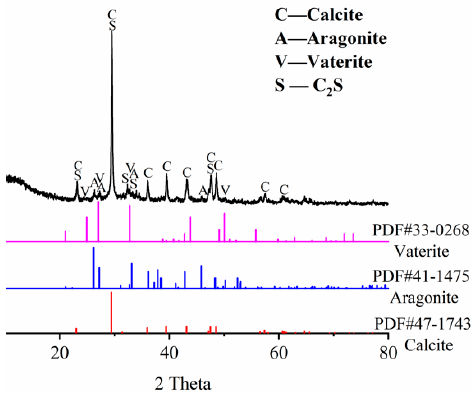
Figure 13. XRD analysis of self-healing products.